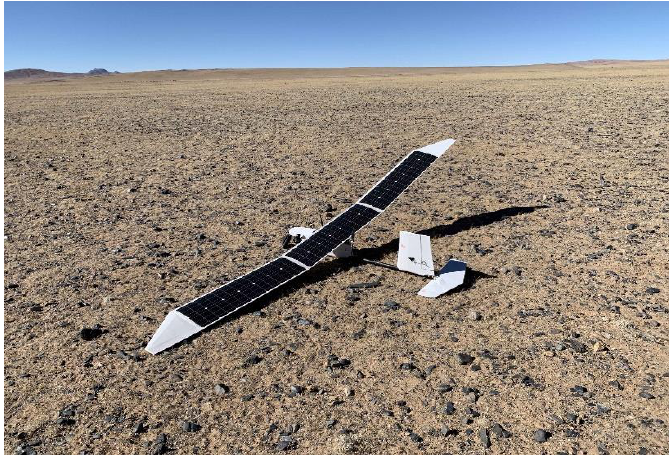
Figure 1. The low-altitude long-endurance (LALE) hand-launched solar-powered unmanned aerial vehicle (UAV) on the plateau.